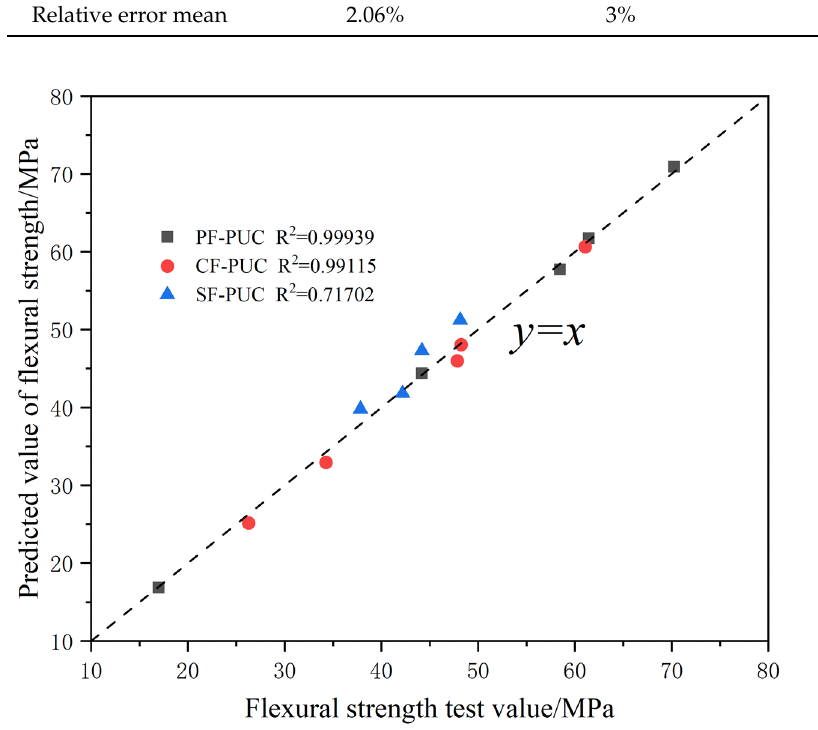
Table 4. Relative error mean of PF-PUC, CF-PUC, and SF-PUC models. PF-PUC CF-PUC SF-PUC Relative error mean 2.06% 3% 9%